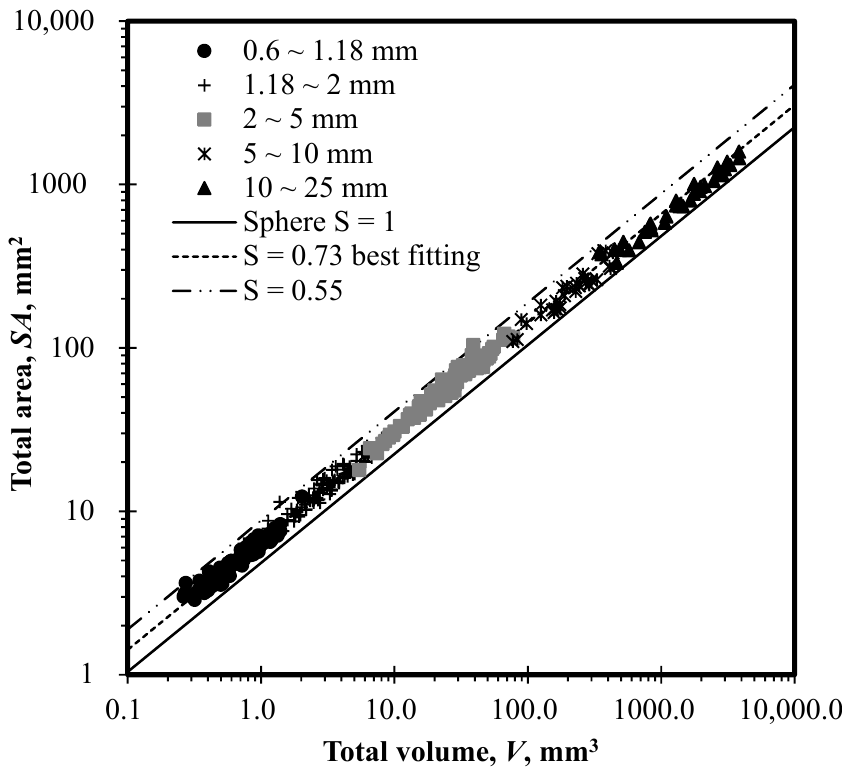
Figure 3. Sphericity as inferred from the relationship between surface area and volume for all particles.